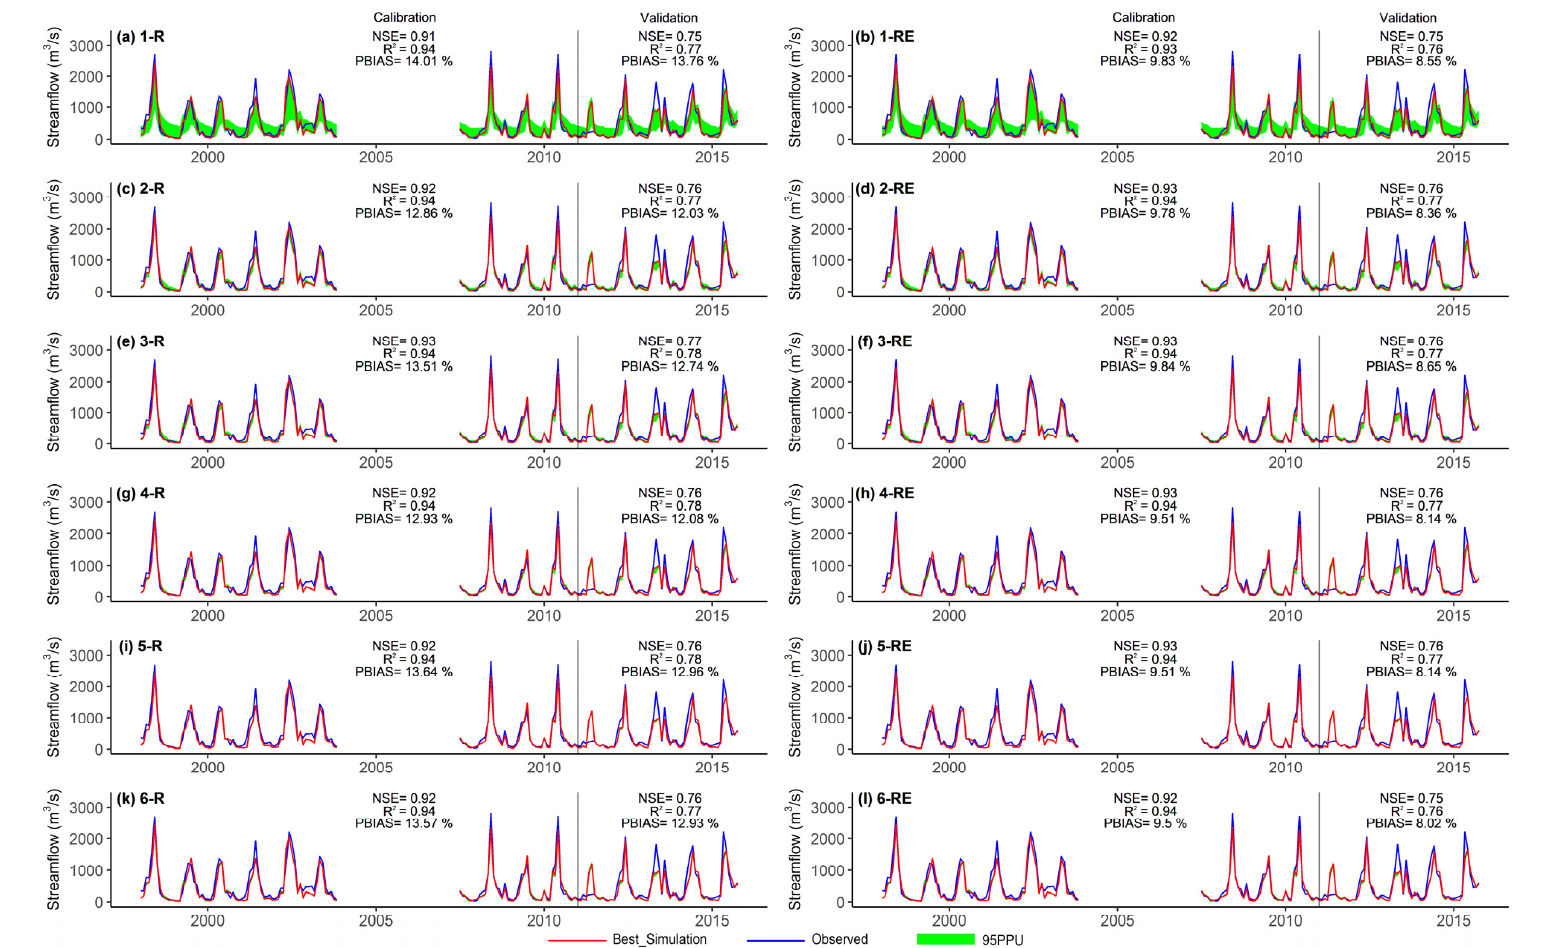
Figure 4. Calibration and validation of SWAT in simulating streamflow at Jingnan gaging station using observed streamflow data only (the left panel) and observed streamflow plus remotely-sensed ET (the right panel). The definition of scenario codes (e.g., 1-R, 1-RE, etc.) marked on the upper left corner of each panel can be referenced to Table 2. ( a – l ) were the codes of 12 scenarios.